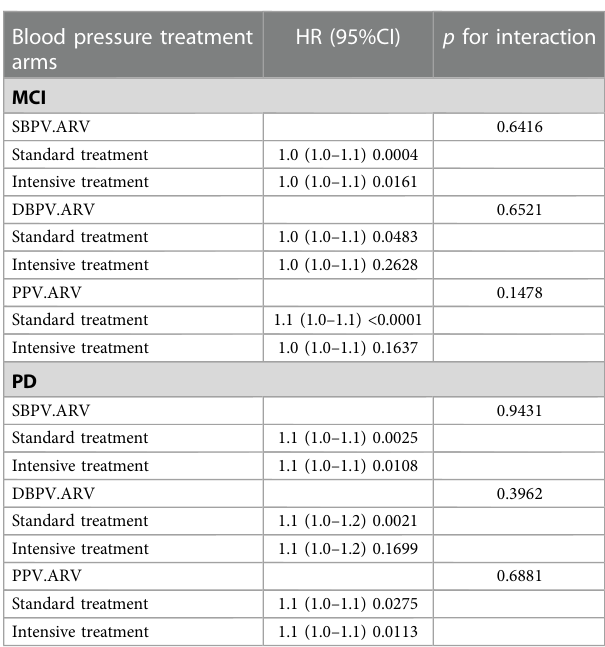
TABLE 4 Interaction analysis between different blood pressure treatment arms (standard blood pressure treatment vs. Intensive blood pressure treatment) on the risk of MCI or PD by BPV (SBPV, DBPV and